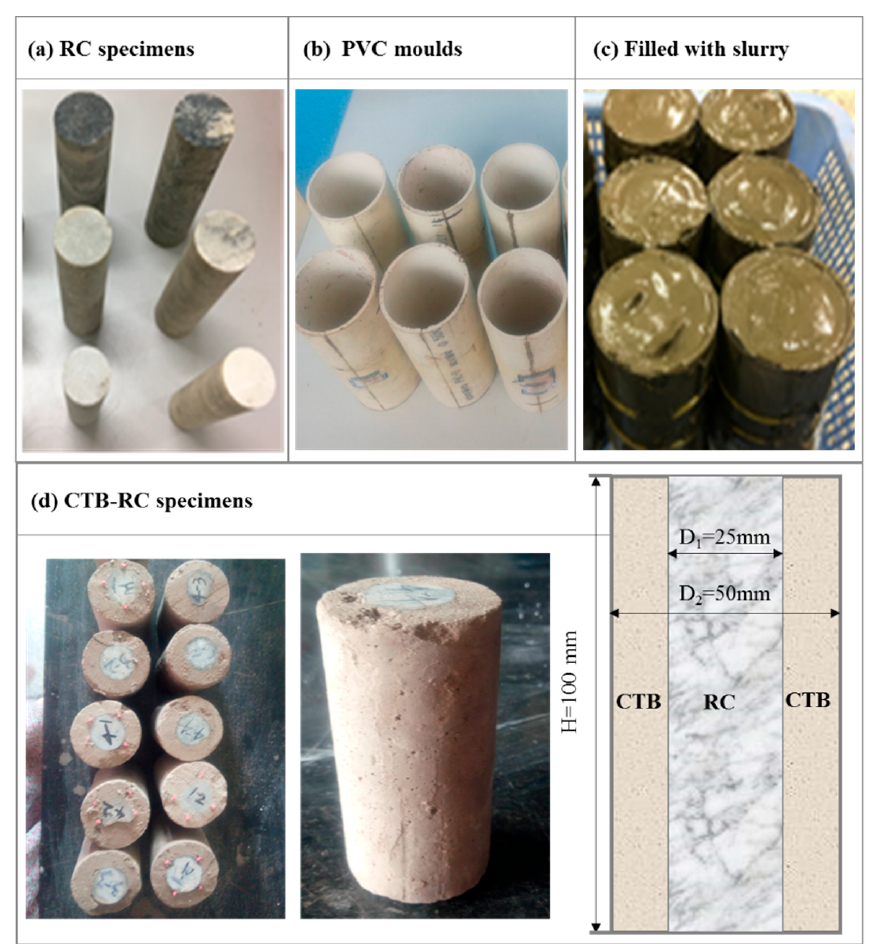
Figure 6. Materials ( a ) RC specimens and ( b ) PVC moulds and preparation process ( c ) Filled with slurry of the ( d ) CTB-RC specimens. Table 4. Number of CTB-RC specimens of different CTR and SC values.